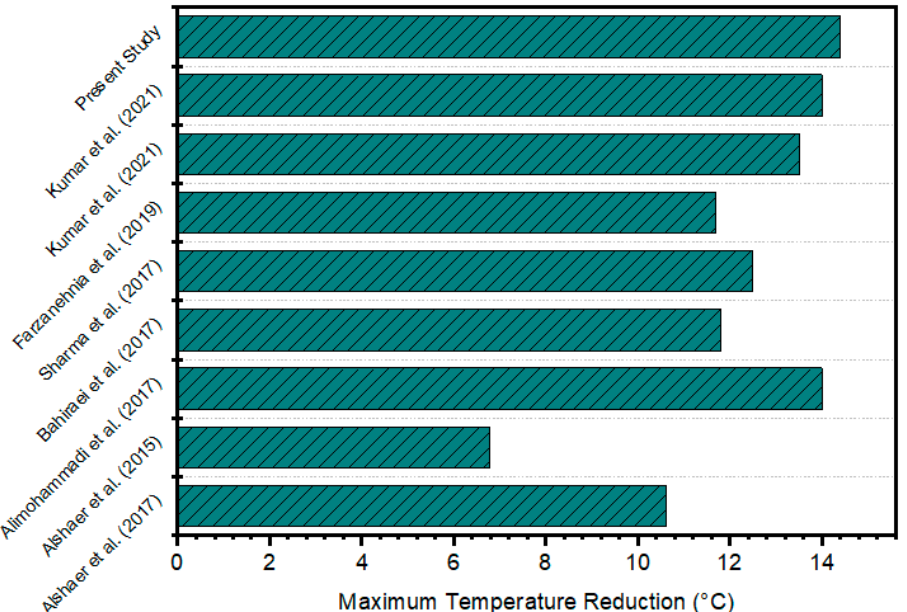
Figure 25. Thermal Management performance comparisons of the present study with the recent studies [11,34–40].